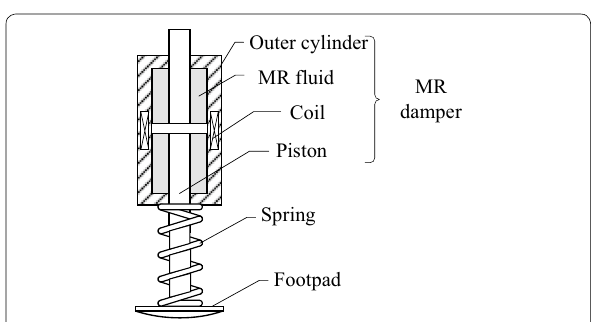
Figure 5 Sketch of adaptive